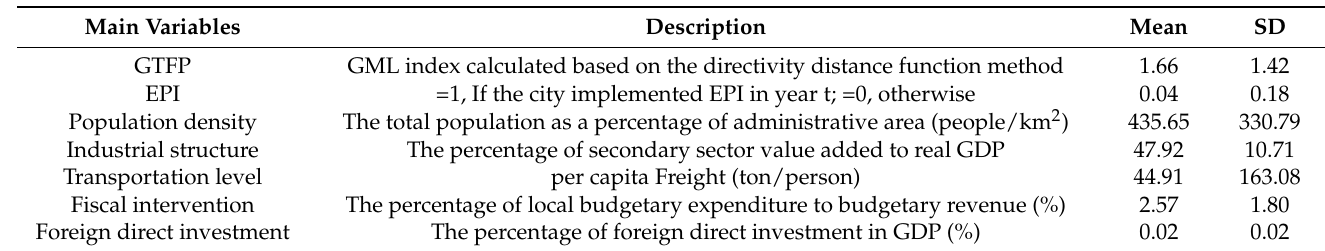
Table 1. Definition and description of